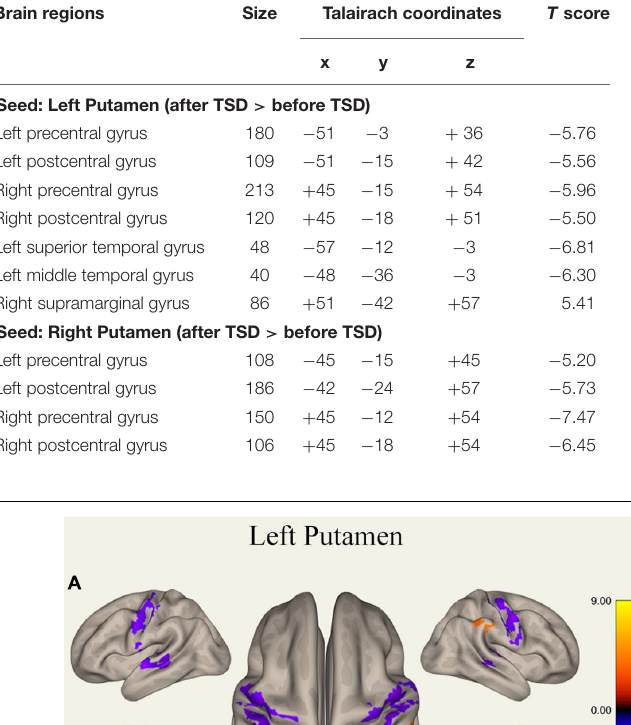
TABLE 1 | Changes in whole brain FC in the bilaterally Putamen before and after 36 h TSD, size of relevant regions, coordinates of MNI and maximum statistical t value ( n = 30).